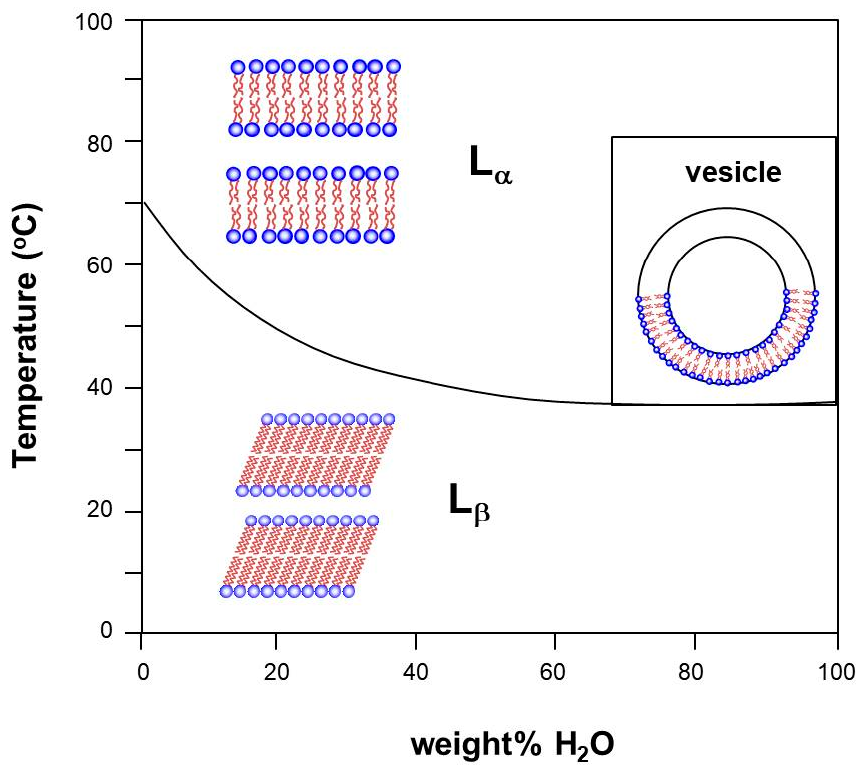
Figure 5. Phase diagram of usual phospholipid membranes, with order (Lamellar L β )–disorder (Lamellar L α ) transition at the Krafft line, in the low-water-content region. Vesicles (unilamellar or multilamellar) are formed in the high-water-content region.